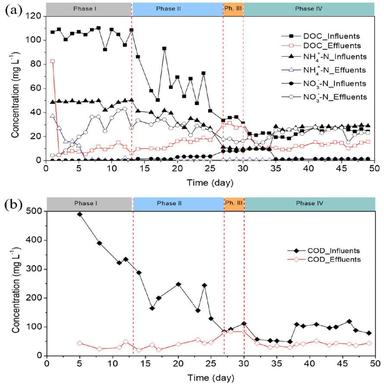
DOC, COD and N-species concentrations in the BAF influents and effluents over time (the operational conditions for different phases were shown in.